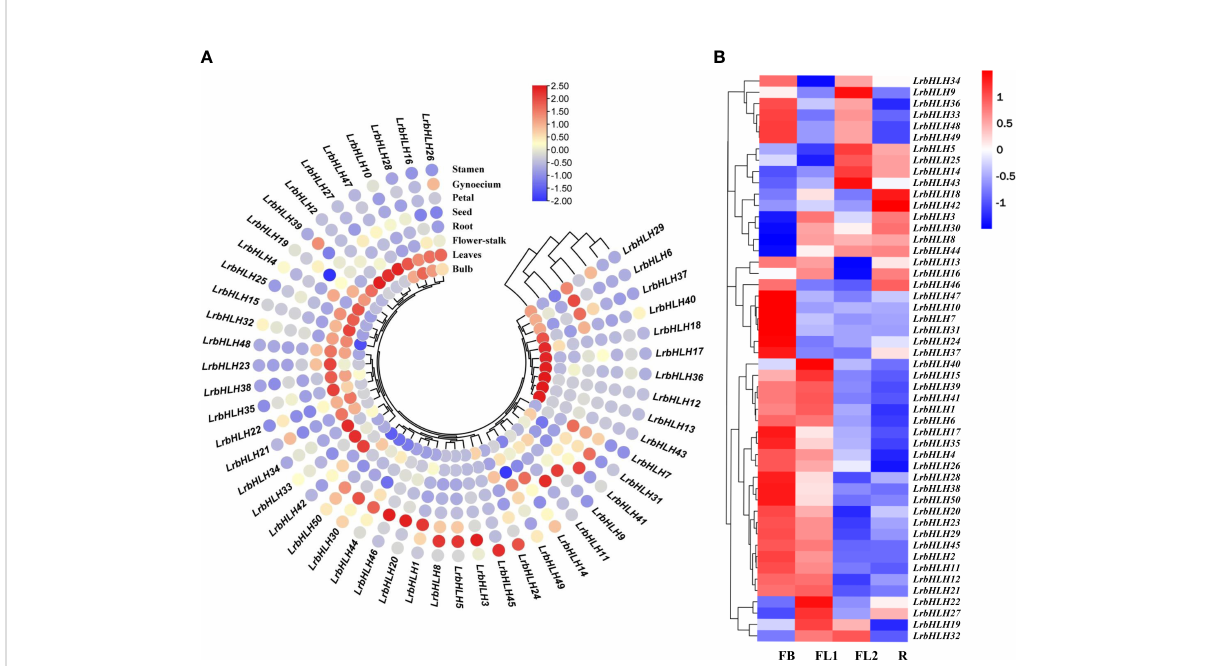
FIGURE 6 LrbHLH gene expression patterns in various L. radiata tissues. (A) Expression pro fi le heatmap with hierarchal clustering of LrbHLHs in different tissues of L. radiata ; (B) Expression pro fi le heatmap with hierarchal clustering of LrbHLHs at different fl ower developmental stages of L. radiata . The relative expression for each genes is depicted by color intensity in each fi eld. Higher values are represented by red whereas lower values are represented by blue. FB, fl ower-bud differentiation stage; FL1, partially opening fl ower stage; FL2, fully opened fl ower stage; R, senescent fl ower